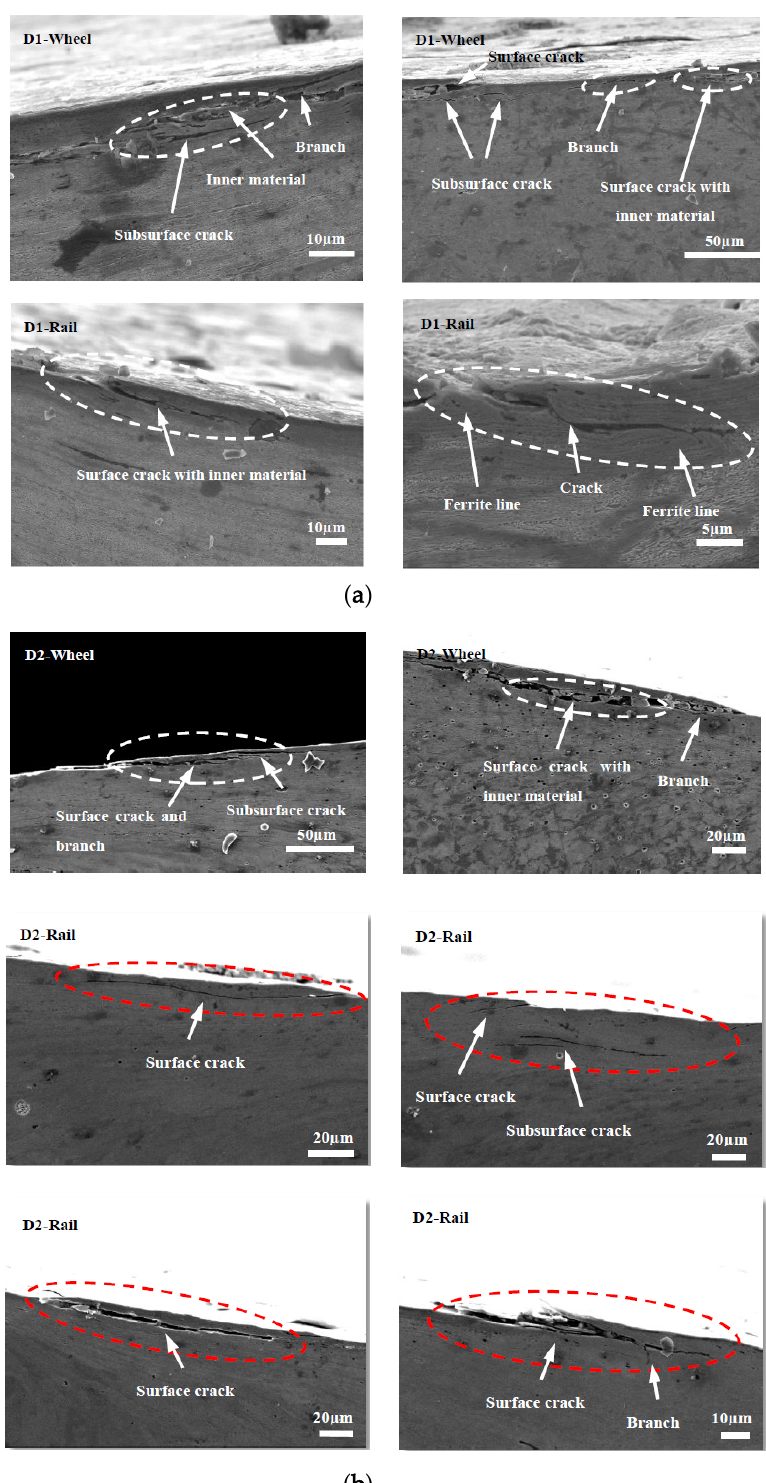
Figure 17. SEM micrographs showing the types of damage of wheel and rail rollers at − 30 °C. (a) D1; (b) D2.